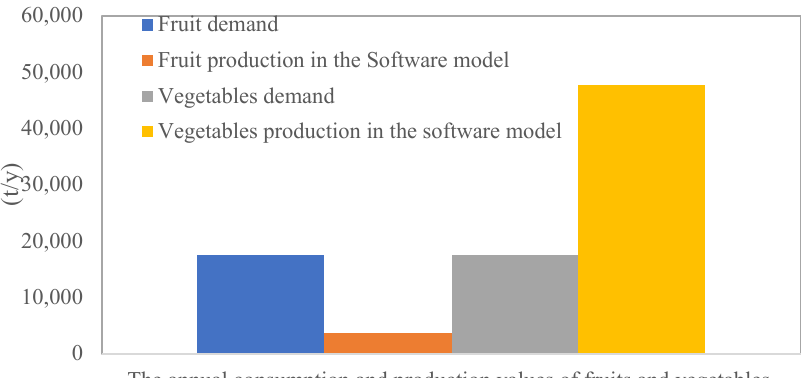
Figure 5. The annual consumption and production values of fruits and vegetables in the urban model of Borujerd for a population of 240,654 .